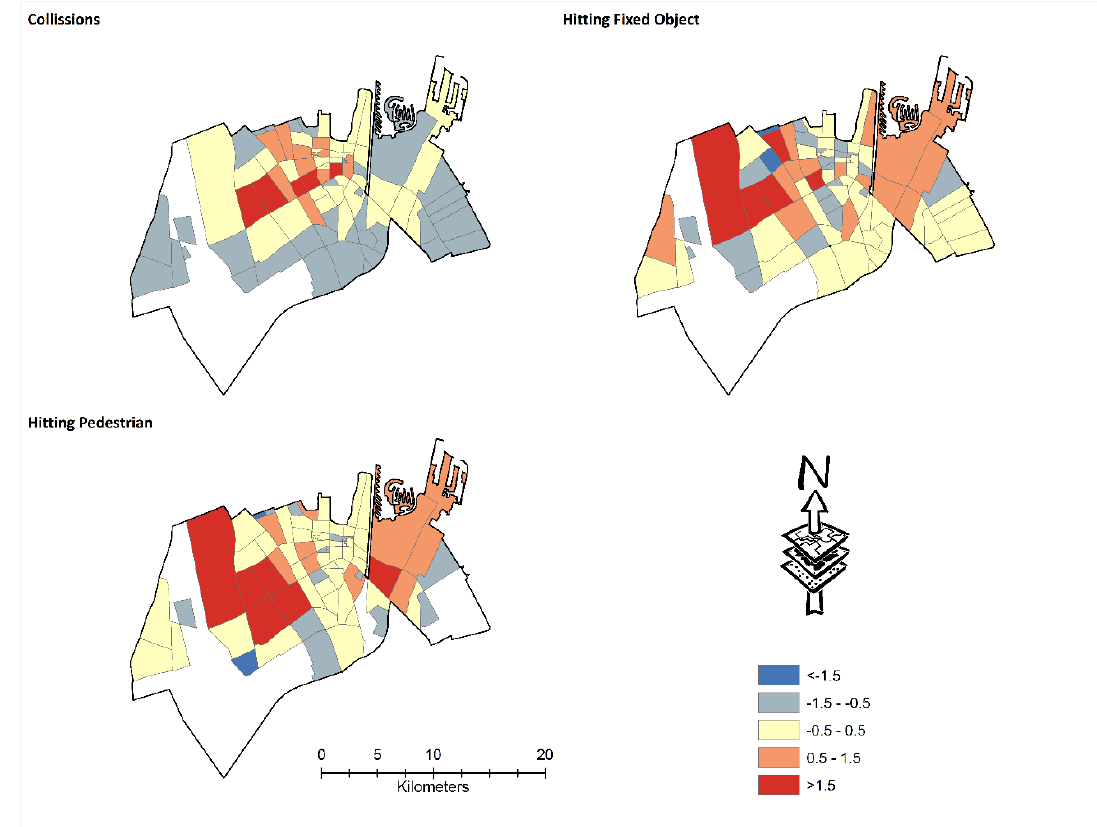
Figure 9. Distribution of the SDR values for different crash types.